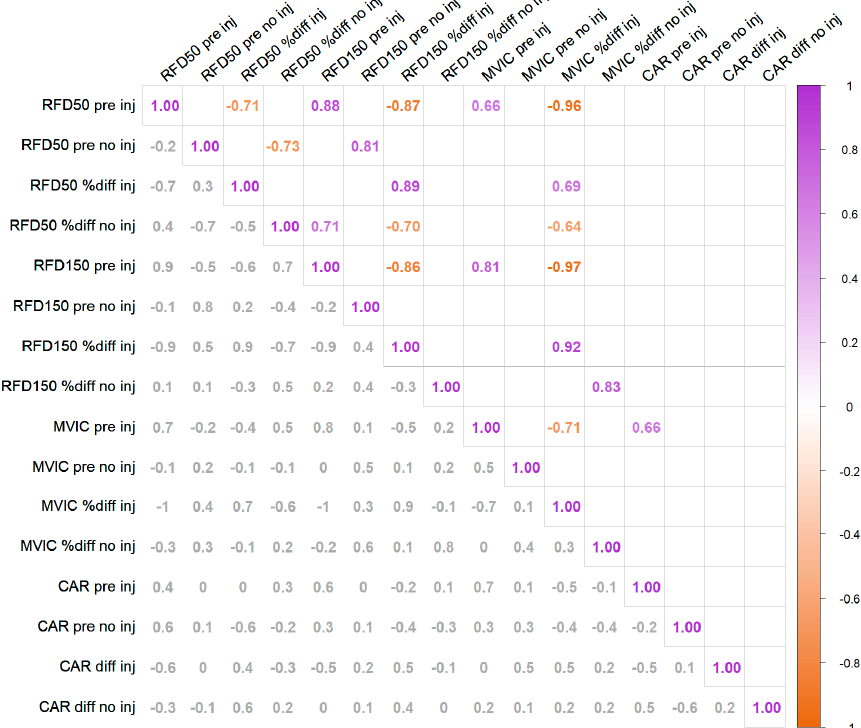
Figure 4. Correlation matrix plot between baseline measure and magnitude of change induced by the intervention. The upper-right part of the matrix only displays significant correlations, with p ≤ 0.05. The bottom left shows all the correlation coefficients regardless of significance, for reference. CAR data from participant #11 were missing and were excluded from this analysis, therefore only data from 10 subjects are included. RFD: Rate of force development 0–50 ms (RFD50) and 0–150 ms (RFD150); MVIC: Maximum voluntary isometric contraction force; CAR: Central activation ratio; pre: measure pre-intervention; %diff: percentage of change between pre and post intervention measurements; inj: injured leg; no inj: non-injured